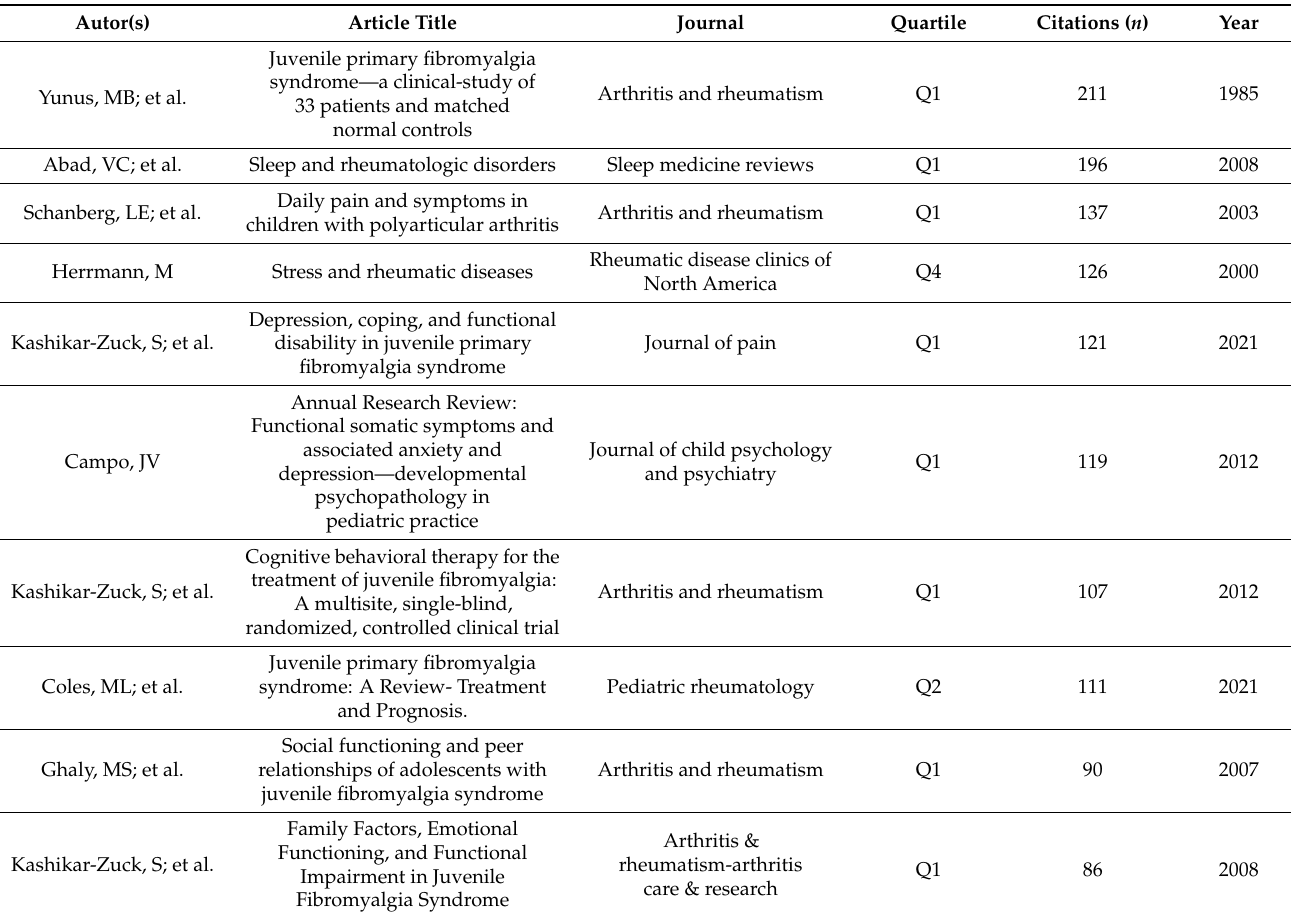
Table 1. Summary of the most cited articles. Abbreviations: Q, Quartile.